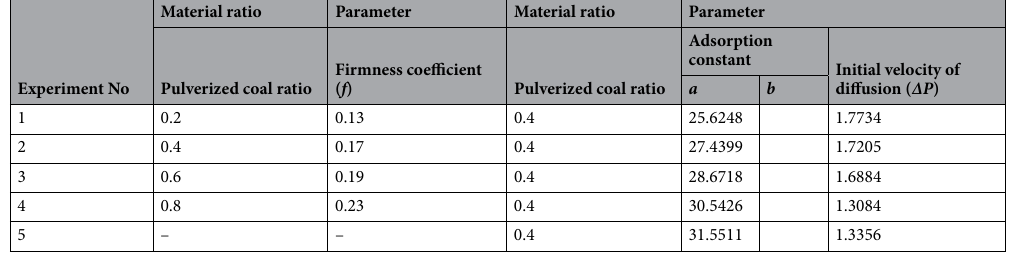
Table 6. Firmness coefficient and adsorption–desorption index of similar materials.